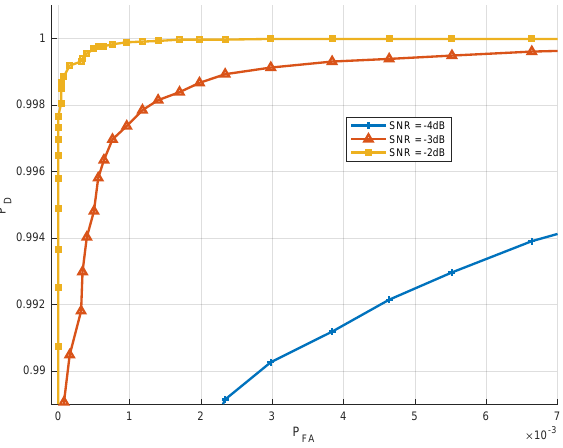
Figure 3. ROC Curve—Detection Probability vs. False alarm for various SNR values.